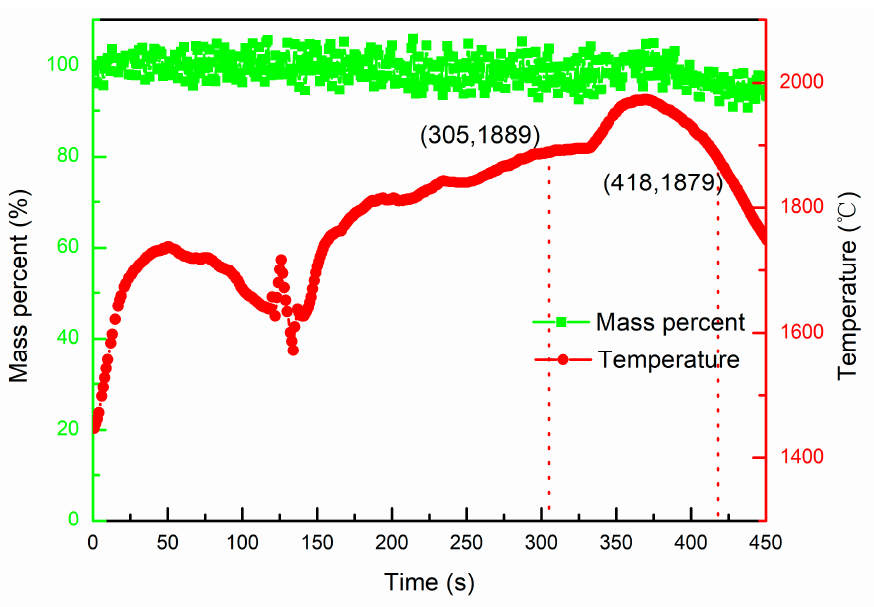
Figure 7. The vacuum evaporation of Al in TC4 alloy by EBM.